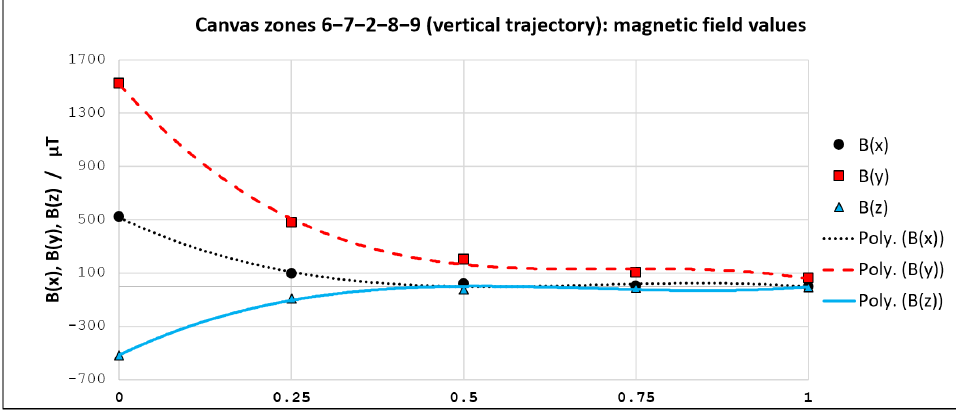
Figure 16. Curve fitting models for the selected vertical trajectory. Table 1. Polynomial functions and related goodness-of-fit values for the selected trajectories in the curve fitting experiment.